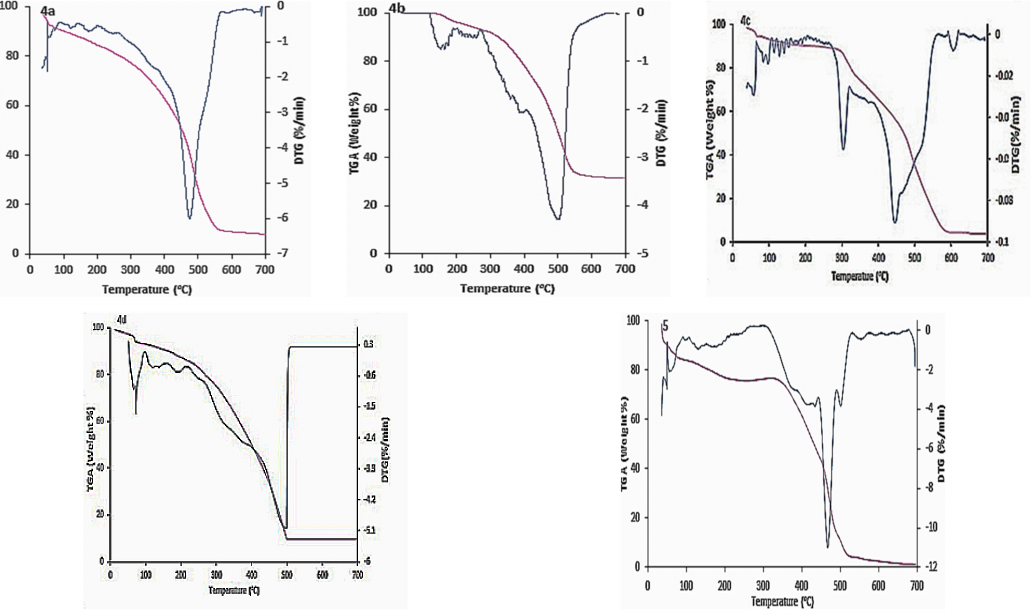
Figure 2. TGA curves with the derivative thermogravimetry (DTG) curves of all prepared pheno- lic polymers.